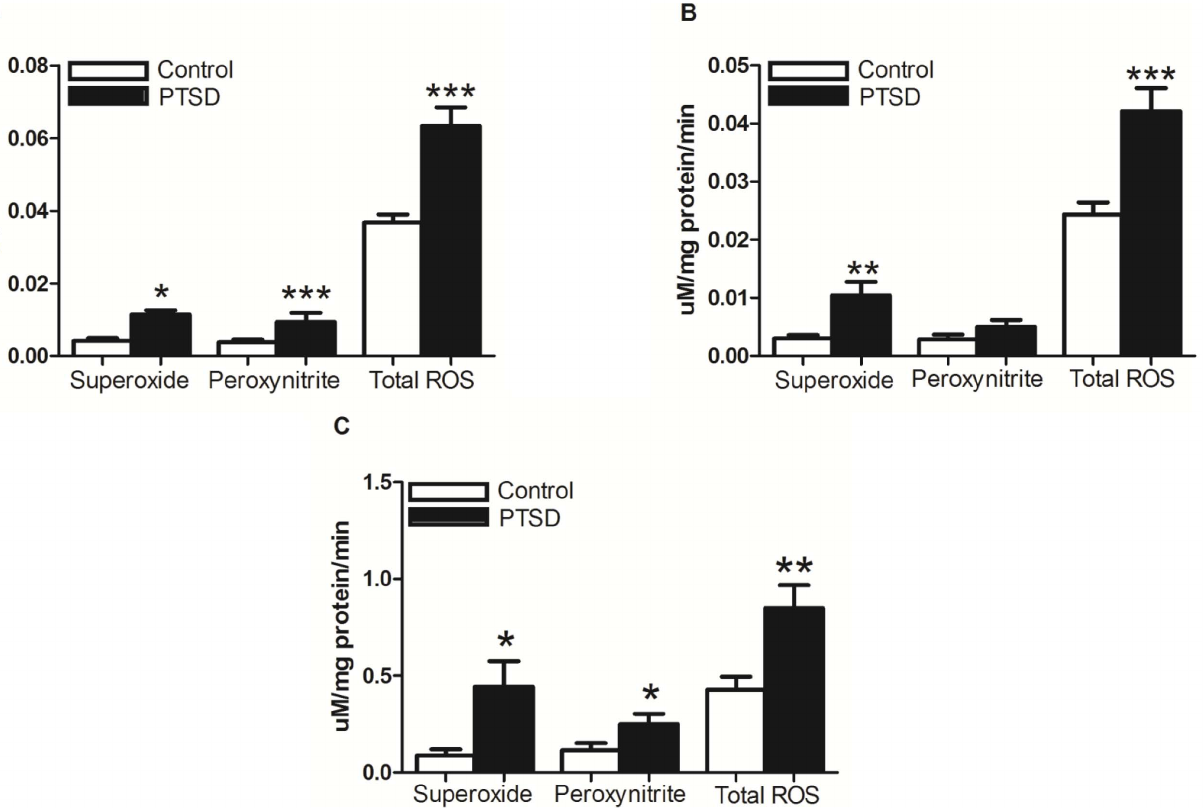
Figure 4. Reactive oxygen species in the brain and adrenal glands. Superoxide, peroxynitrite, and total ROS were all significantly elevated in the hippocampus (A) and adrenal glands (C) in the PTSD group. Superoxide and total ROS were also elevated in the pre-frontal cortex (B) in the PTSD group, but peroxynitrite did not reach significance. All data are presented as mean 6 SEM. *p , 0.05, **p , 0.001, ***p , 0.0001 relative to the control group.